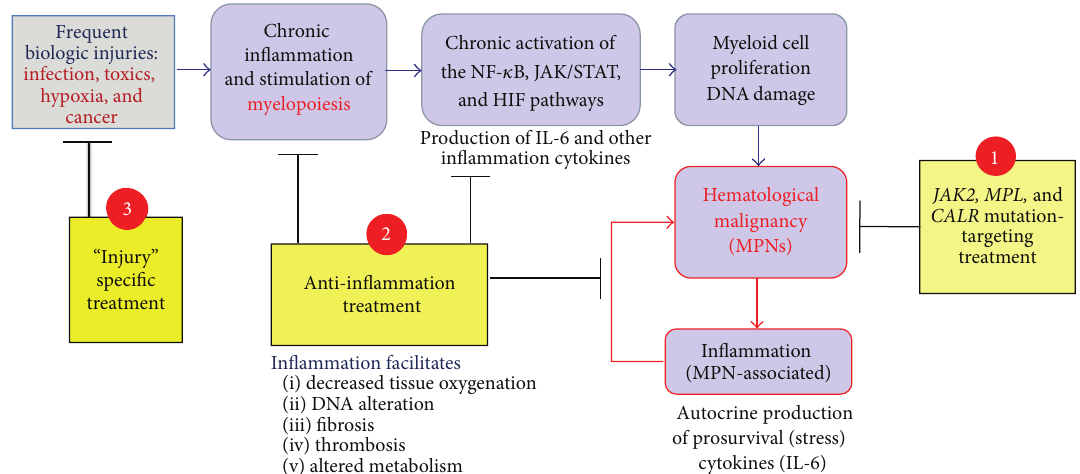
Figure 5: Chronic inflammation in myeloid neoplasms and new therapeutic options. In MPN patients, chronic inflammation includes the participation of JAK2 -V617F-, MPL -W515 L/K-, or CALR -mutated cells and the production of inflammation cytokines under the control of these mutations. Chronic inflammation may also be reactive to the MPN clone or to other coexisting causes of inflammation (hypoxia due to cell accumulation in the bone marrow; thrombosis; infection; others). Healthy and mutated (clonal) myeloid cells participate in MPN- associated reactive inflammation, and the NF- 𝜅 B, JAK/STAT, and HIF pathways are chronically activated in the MPN clone and in cells from the bone marrow environment. Ideally treatment should combine the following: (1) inhibition of the JAK2 -V617F, MPL -W515L/K, or CALR mutations, possible with JAK inhibitors; (2) inhibition of chronic inflammation, via the neutralization or inhibition of inflammation cytokines or receptors, and/or the inhibition of the NF- 𝜅 B and HIF pathways; (3) in cases where chronic inflammation precedes mutation, and a cause is identified, adequate treatment of the initial cause of inflammation could be added (e.g., antibiotics or antiviral treatment in case of latent